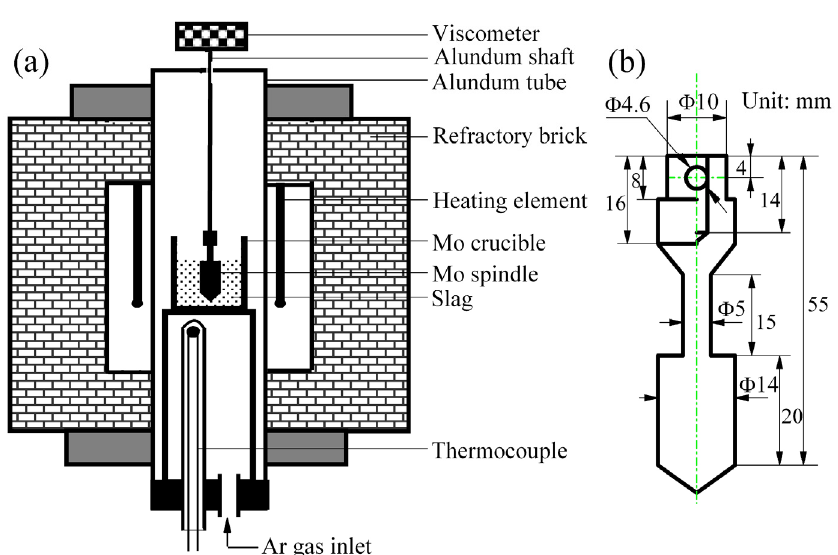
Figure 1. The schematic diagram of viscosity measurements. ( a ) Experiment apparatus; ( b ) Mo spindle.